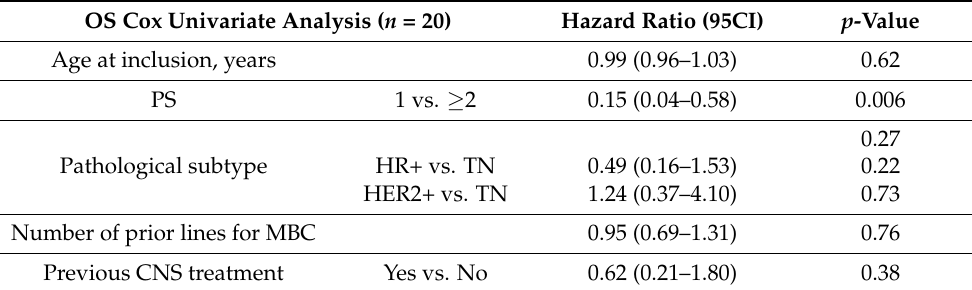
Figure 3. Overall survival Kaplan–Meier curve. Table 3. Overall survival (OS) cox regression univariate